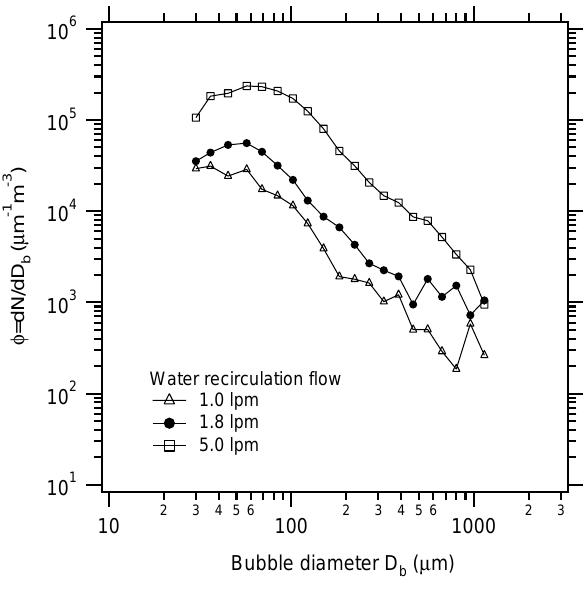
Fig. 2. Bubble population distribution versus bubble diameter for the plume generated by the plunging-water jet system at different water recirculation